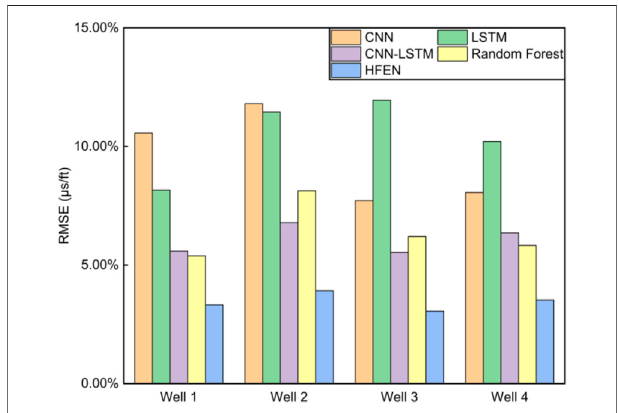
FIGURE 16 | Comparison of predicted results ( R 2 ) between HFEN and other networks: CNN, LSTM, base CNN-LSTM, and random